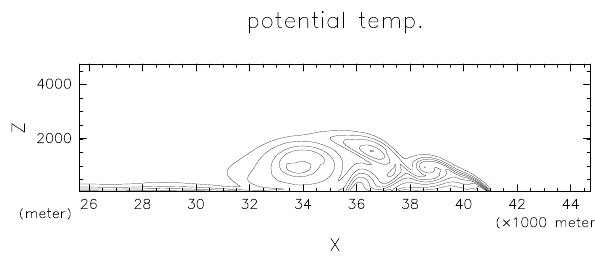
Figure C1. Plot of potential temperature at t = 900s of the 100m resolution density current experiment. Contour interval is 1K, and contours are centered around 300K.